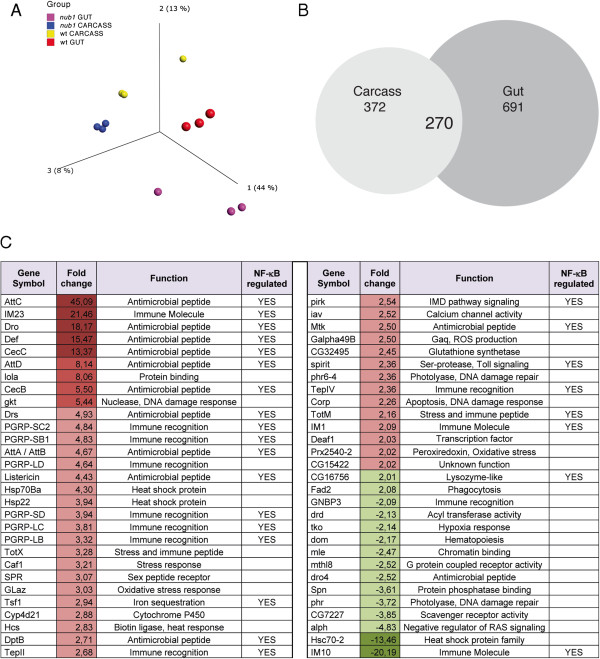
Analysis of global mRNA expression profile in nub1 mutants compared to wild type flies. (A) A factorial map of principal component analysis was conducted using all transcripts found to be expressed over background signal in at least one sample group. Samples are colored group-wise. The percentage found for each component in the plot can be interpreted as the variation seen within and between the different sample groups. For the principal component analysis plots, the largest explainable variance is found in component 1, where 44% of the data’s variation can be explained. This 44% is the biological difference found between the different tissues, gut or carcass. Component 2 with its 13% divides the data based on the biological variance explained by strain, that is, nub1 or wild type (wt). Component 3, with 8%, biologically nuances the data even further. (B) Venn diagram showing the overlap of carcass and gut differentially expressed genes in nub1 compared to wild type after removing background and filtering for fold change >2. (C) List of ‘Immune and Stress Response’ genes up- or down-regulated in nub1 mutants. Names and functions of the 58 genes constituting the enriched Biological Process cluster ‘Immune system and Response processes’ identified by a gene set enrichment analysis (Additional file 4) in carcass (without head and gut) from nub1 mutants. Fold change (mean values) of mRNA levels is indicated by numbers and color-coded (red, up-regulation; green, down-regulation). Genes that previously have been shown to be targets of the NF-κB/Relish/IMD pathway or a combination of NF-κB/Relish/IMD and NF-κB/Dif/Toll pathways [44-46] are indicated by ‘YES’.